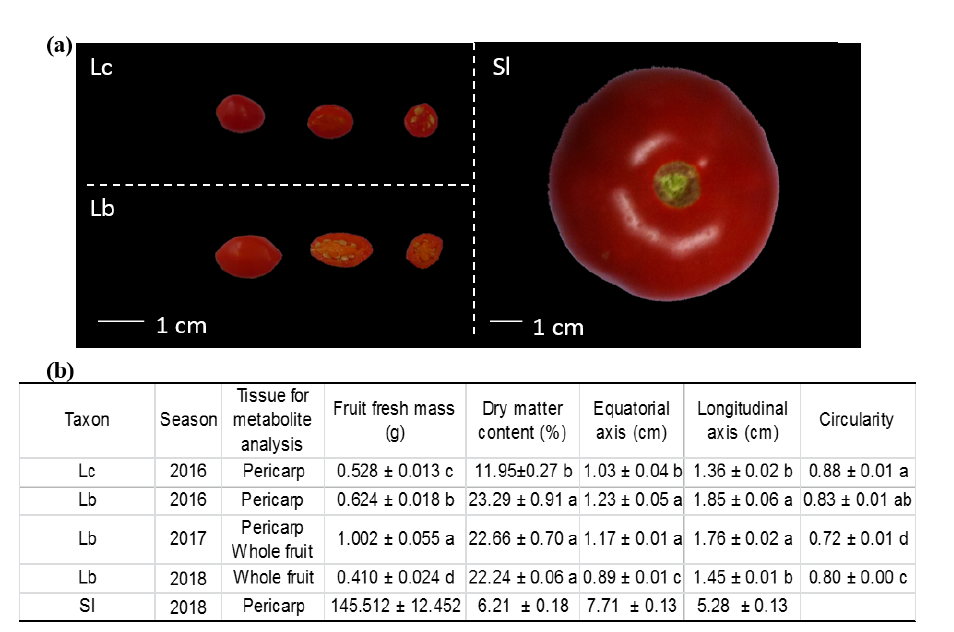
Figure 2. ( a ) Variations in morphological traits of 2 goji ( Lycium chinense (Lc) and Lycium barbarum (Lb)) and tomato fruits Solanum lycopersicum (Sl). ( b ) Data on fruit harvest, fresh mass, dry matter content, size and circularity. Data are means ± standard errors ( n > 4). Different letters indicate significant differences between Lc 2016, Lb 2016, 2017 and 2018 at α = 0.05. Accessions present significant variations in dry matter contents, Lb showing the highest values.